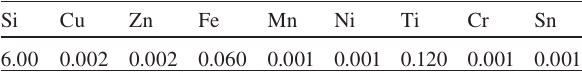
Table 1 Chemical composition of as-received Al-Si alloy (wt. % ). Si Cu Zn Fe Mn Ni